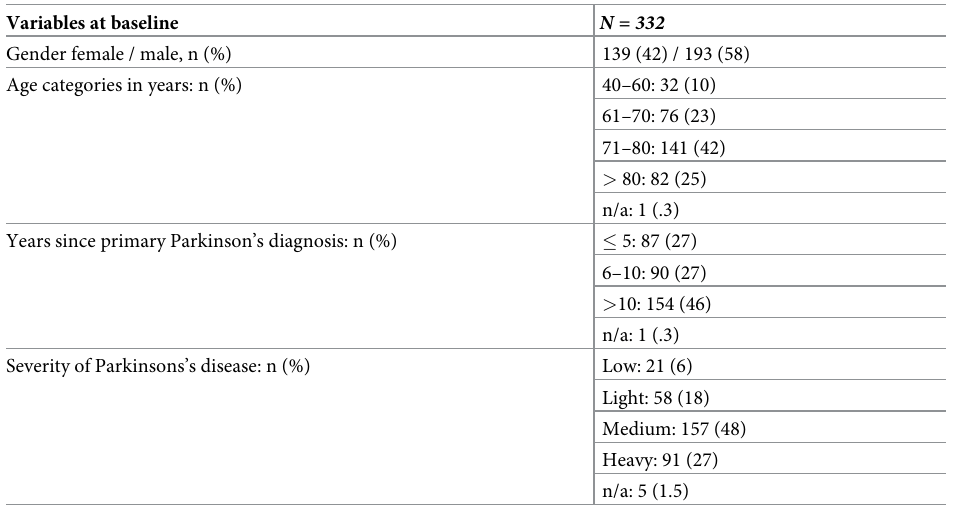
Table 2. Table of demography—Patient characteristics at baseline. Variables at baseline N = 332